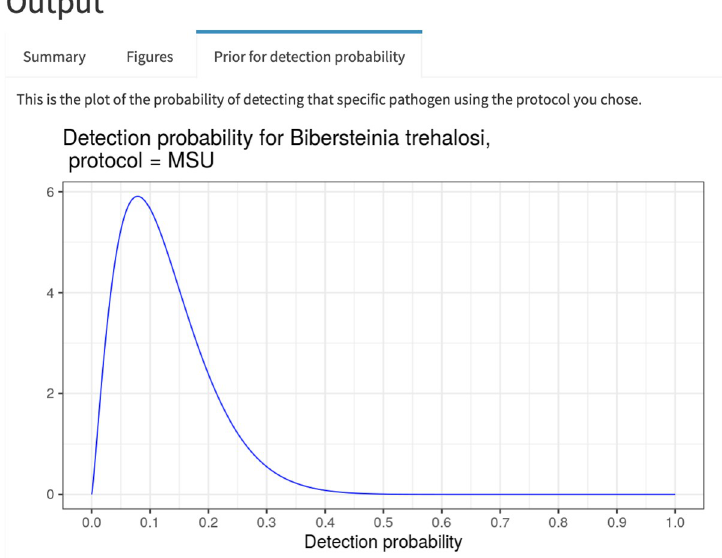
Fig 6. Graph of the informed prior distribution. This is the separately estimated probability of detecting Bibersteinia trehalosi with the MSU protocol. Priors for detection probability were extracted from previous work